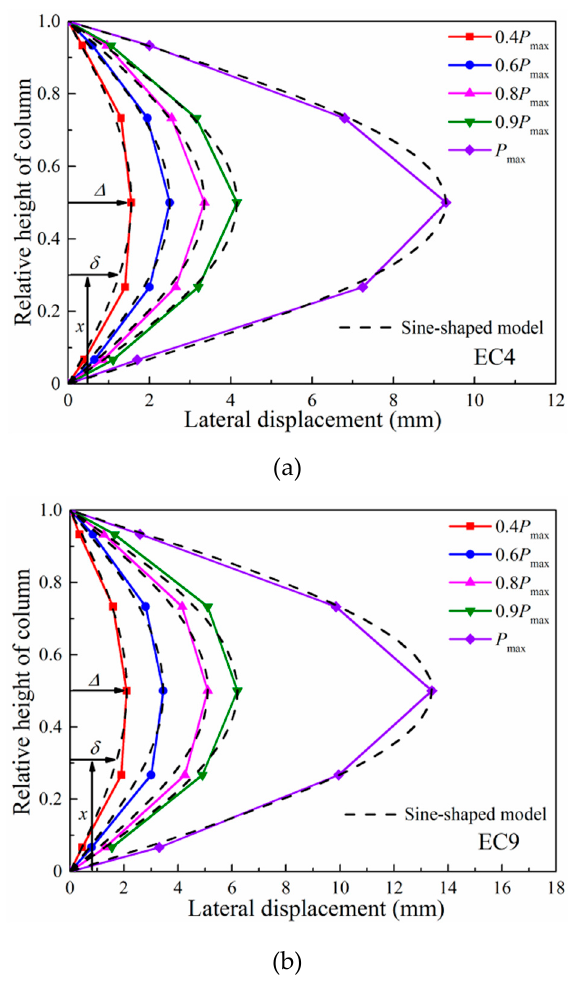
Figure 6. Lateral deformation of columns: ( a ) EC4 ( e = 79 mm); ( b ) EC9 ( e = 179